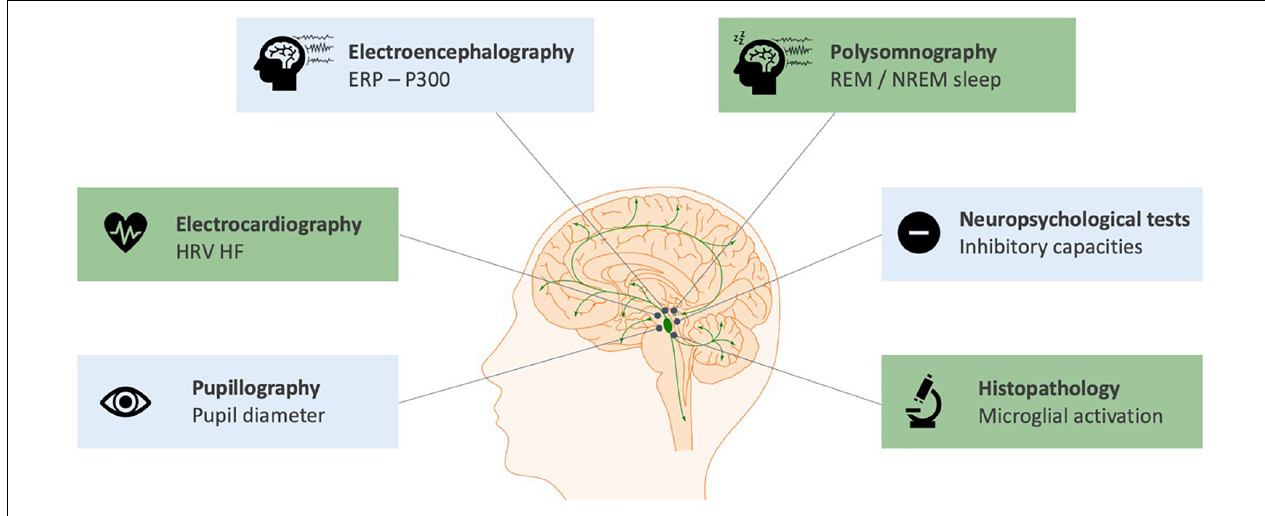
FIGURE 2 | Biomarkers of the short-term (blue) and long-term (green) modulation of the LC-NE system with cervical VNS in humans. The scientific figure was partially created using the illustration Toolkit – Neuroscience from Motifolio,